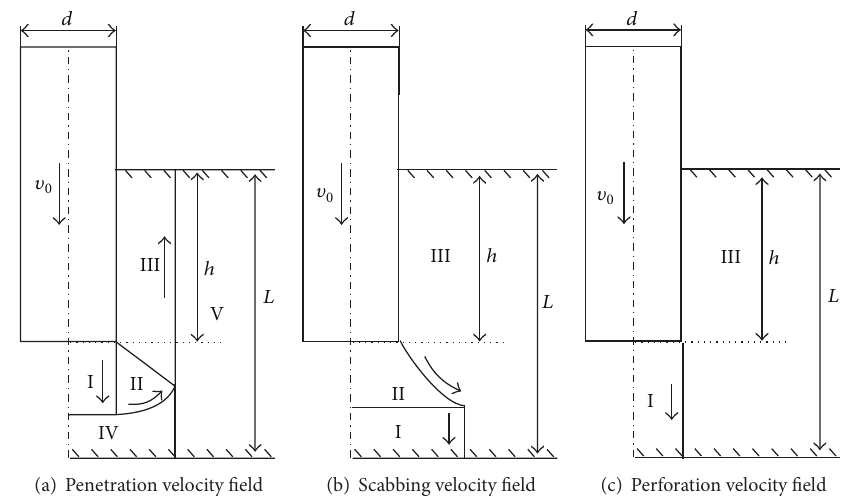
Figure 4: Permissive velocity fields of target under low velocity impact.